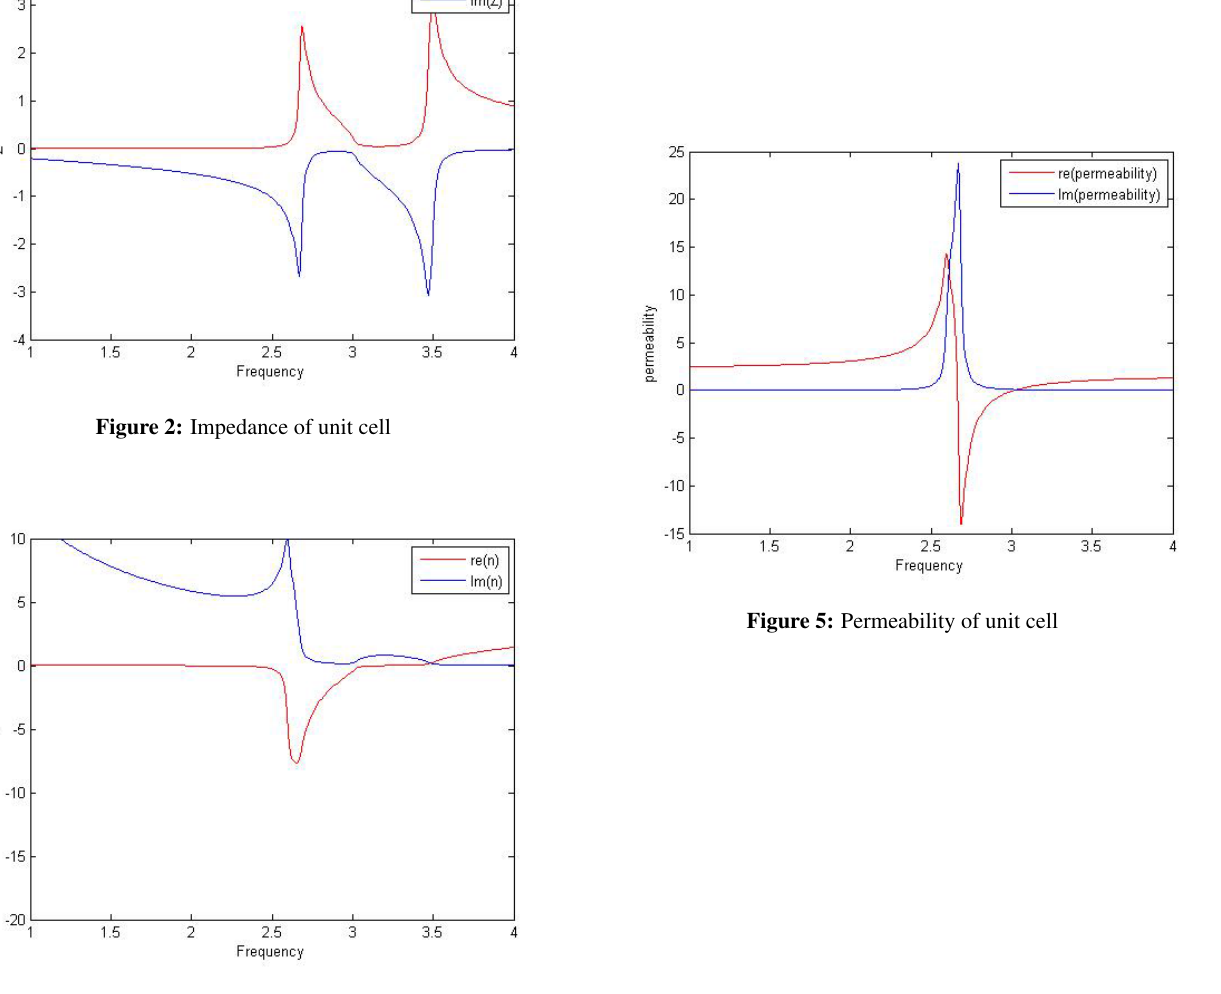
Figure 3: Refractive Index of Unit Cell